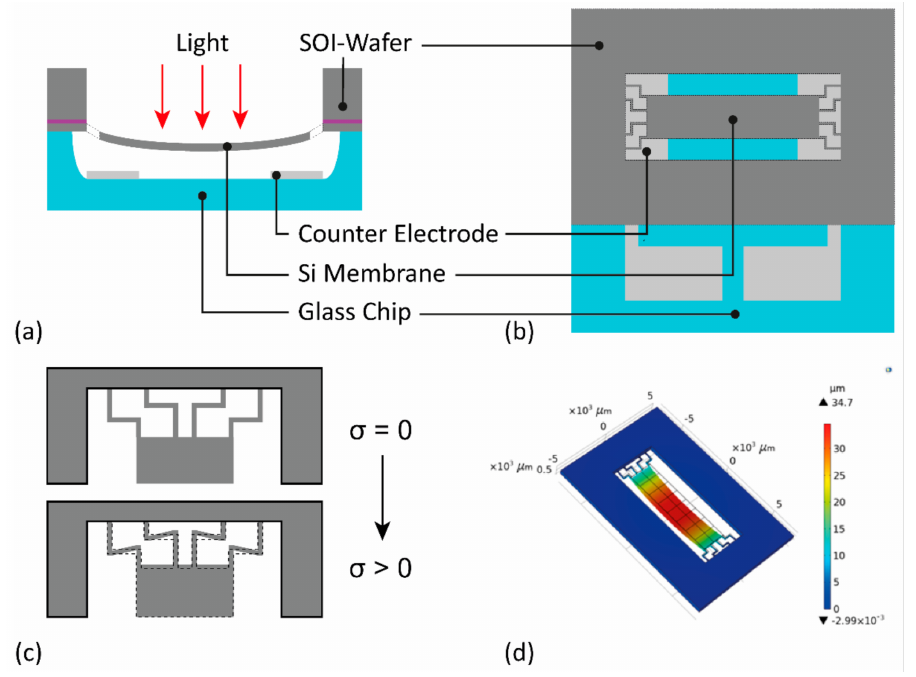
Figure 2. Schematic cross section ( a ) and top view ( b ) of the MAAM mirror. An incoming collimated ray bundle is reflected to a focus defined by the parabolic profile of the Si membrane. ( c ) To avoid buckling of the reflecting membrane surface by internal residual stress in the membrane material, special beams are used as suspensions of the membrane to the rim. ( d ) FEM simulation of the electrostatically deformed MAAM showing the parabolic deformation in the long axis and a flat